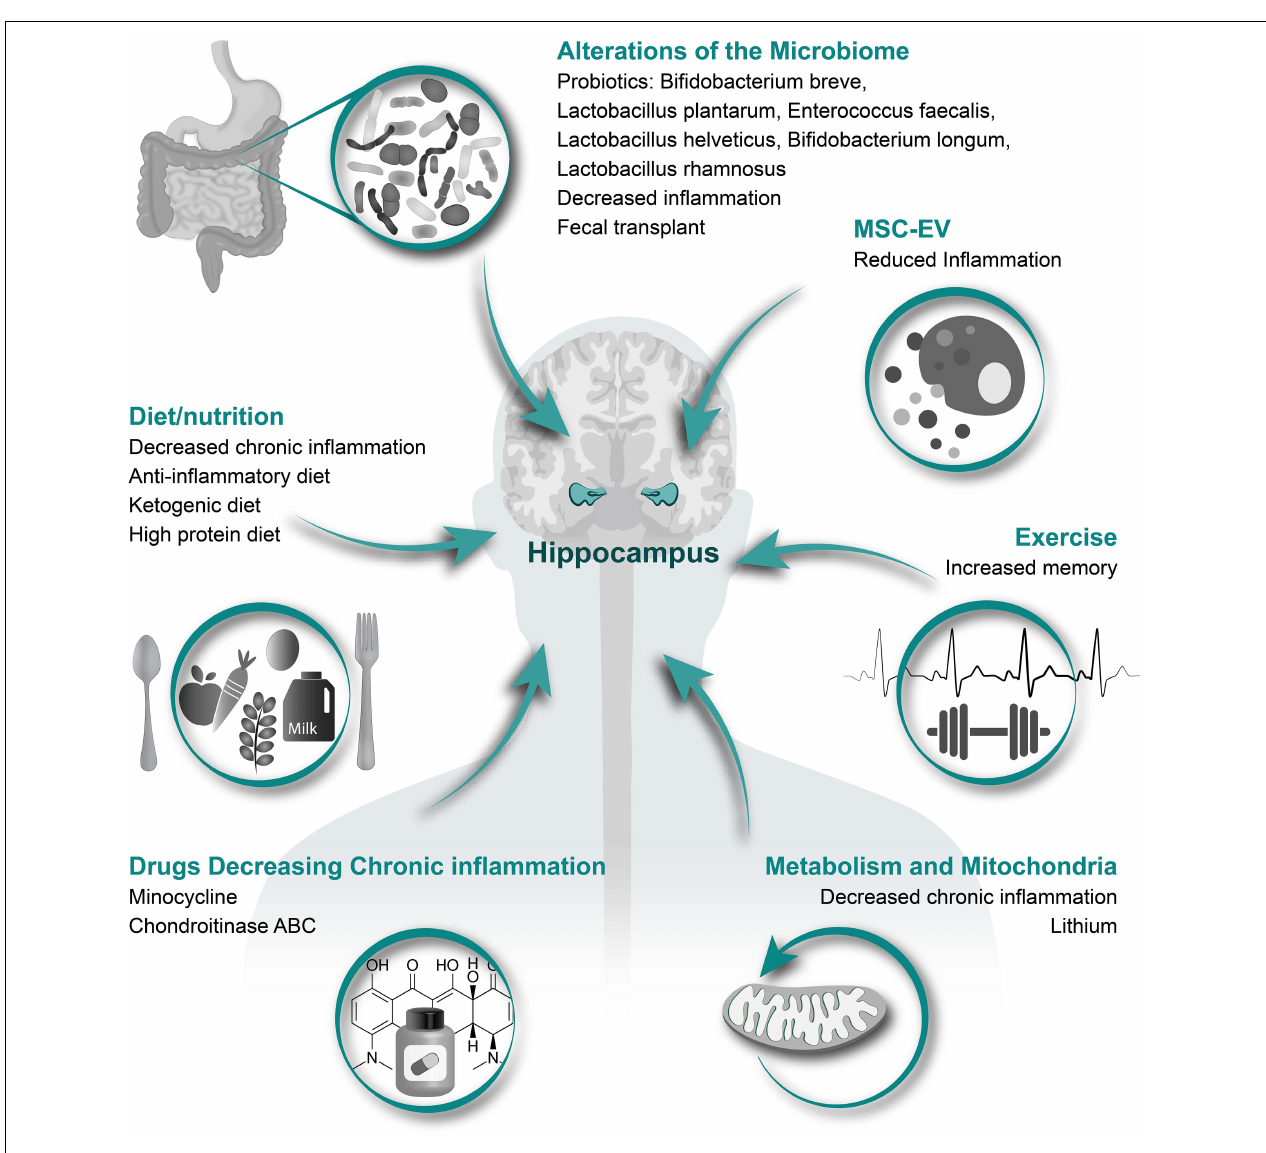
FIGURE 3 | Therapeutic options to increase hippocampal neurogenesis. Illustrated here are several different categories of therapeutic options that have potential to alleviate the SCI induced reduction in hippocampal neurogenesis with specific treatment options and potential affects listed underneath each